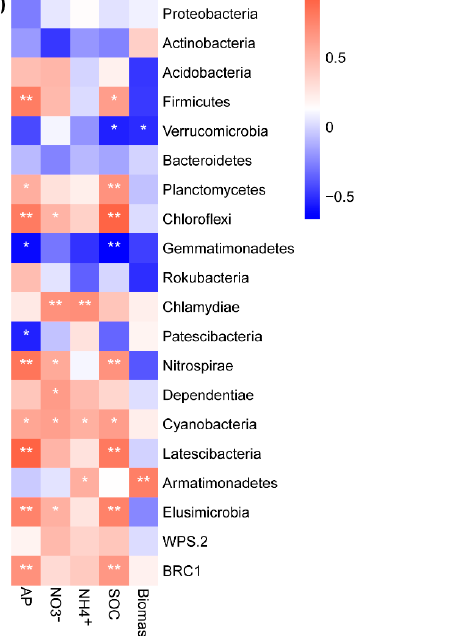
, soil nitrate nitrogen; NH + , soil ammo- 3 4